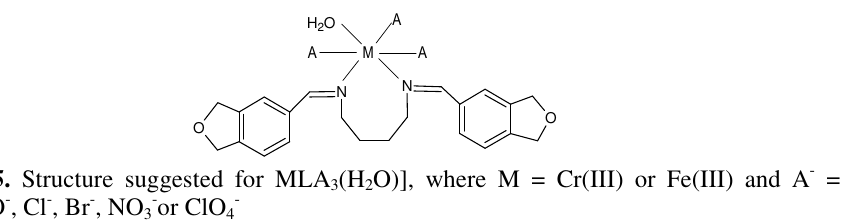
(H O)], where M = Cr(III) or Fe(III) and A - = 3 2